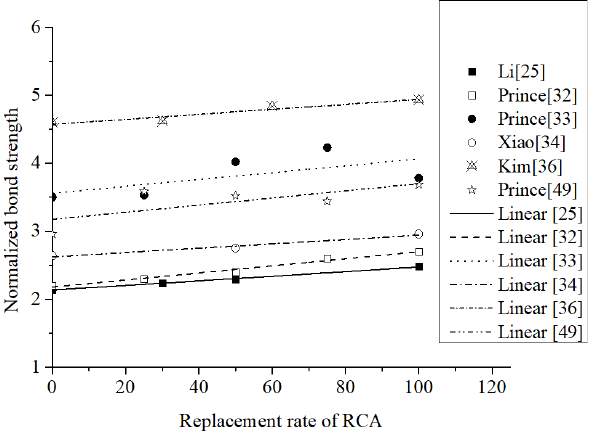
Figure 4: Normalized bond strength versus replacement rate of RCA